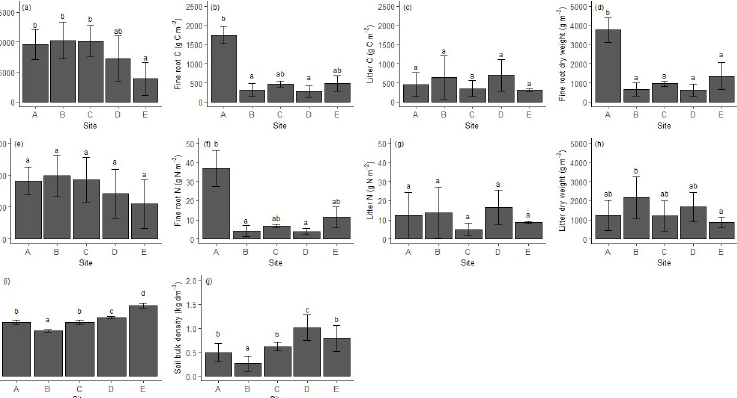
Fig 2. Stocks of C and N in soil and biomass (a-g); litter dry weight (h); soil pH (i); and soil bulk density (j), in the examined sites (A-E). Different letters indicate significant differences between sites. Vertical bars represent the standard deviation of the